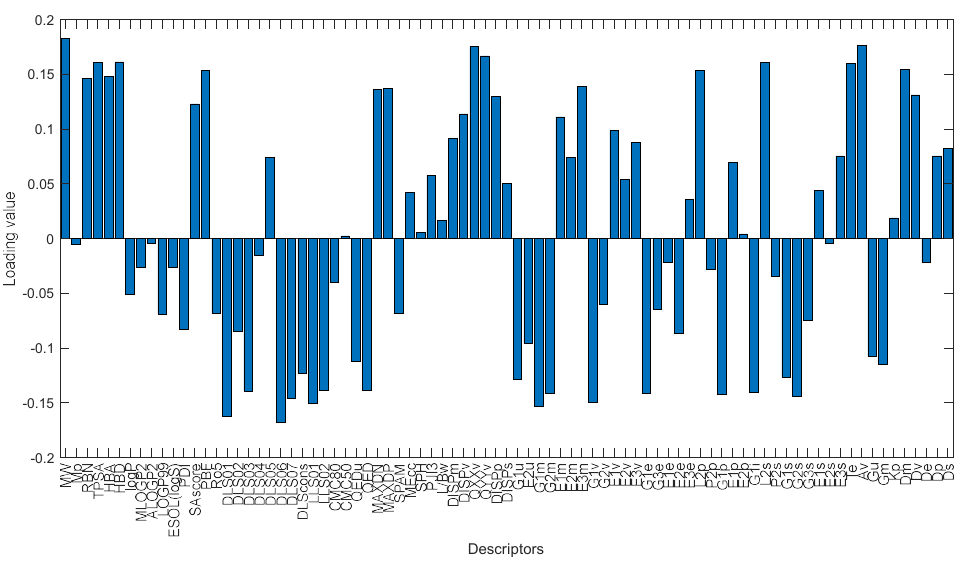
Figure 18. Bar plot of the loading values of 1st PC.